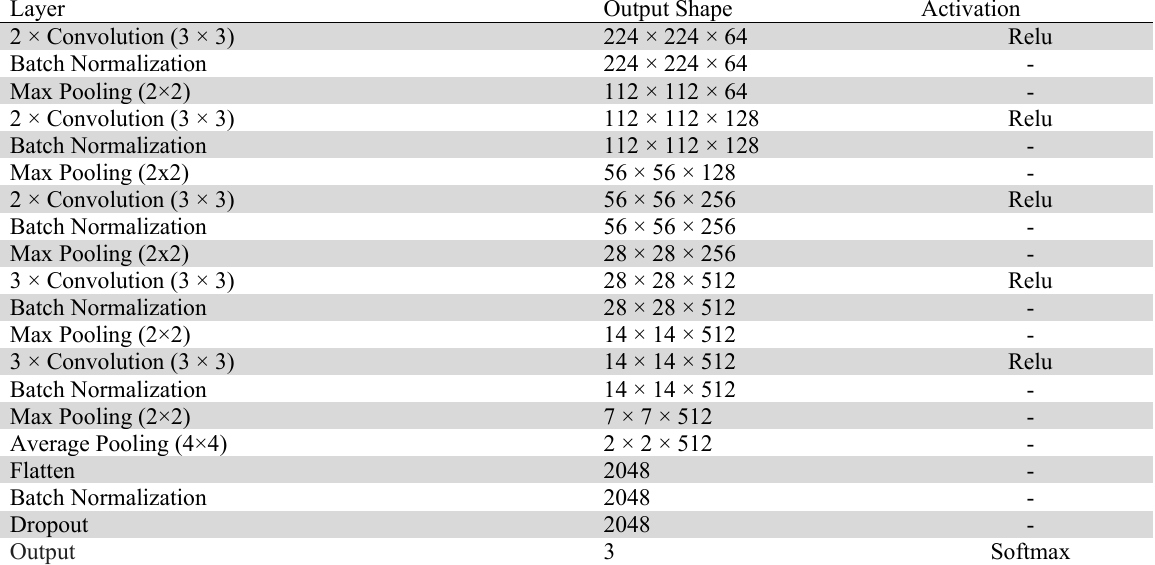
The summary of CNN model